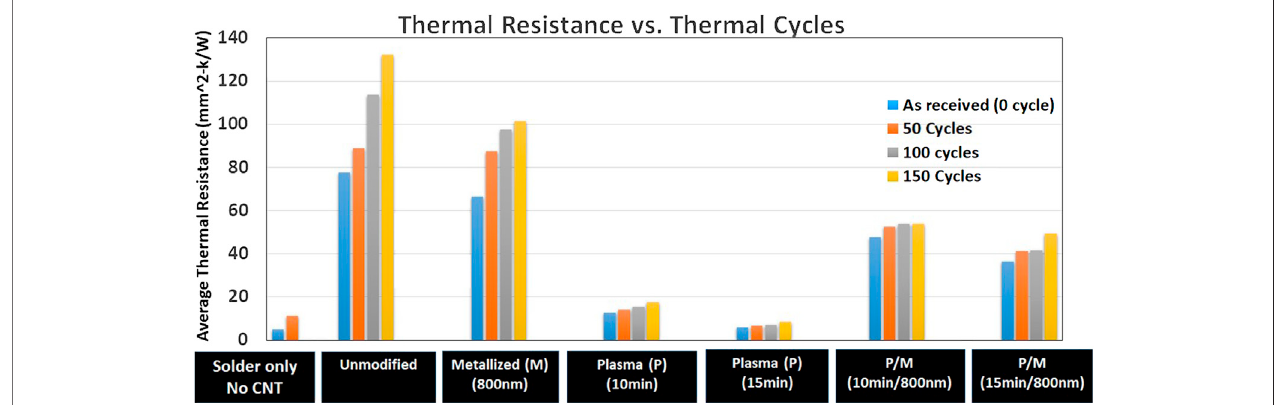
Frontiers in Materials |